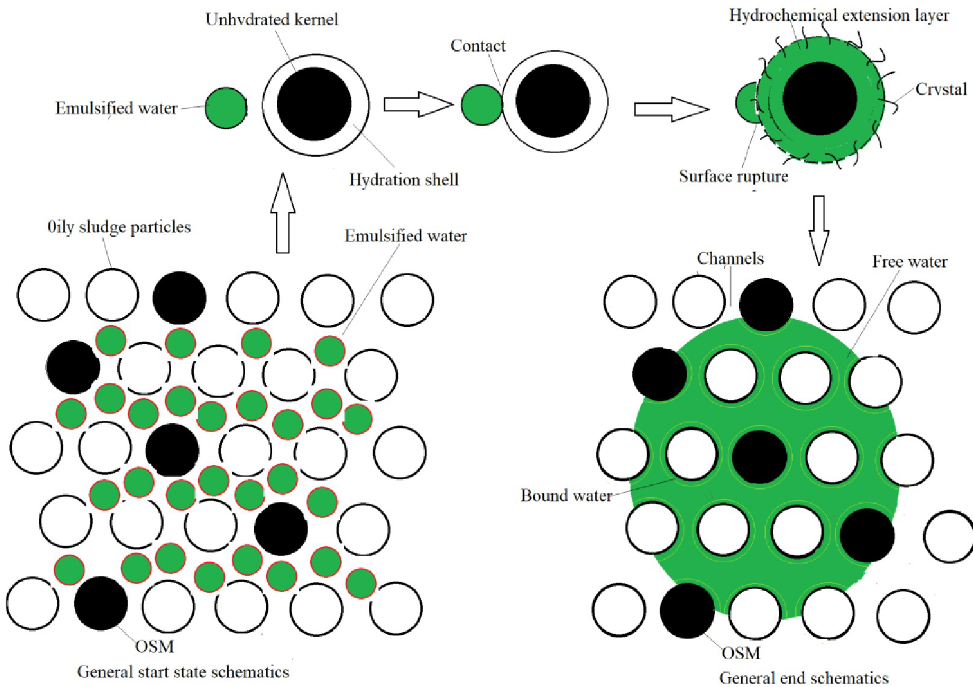
Fig 8. A schematic diagram of damage to emulsion surface film during hydration of inorganic cementing materials.